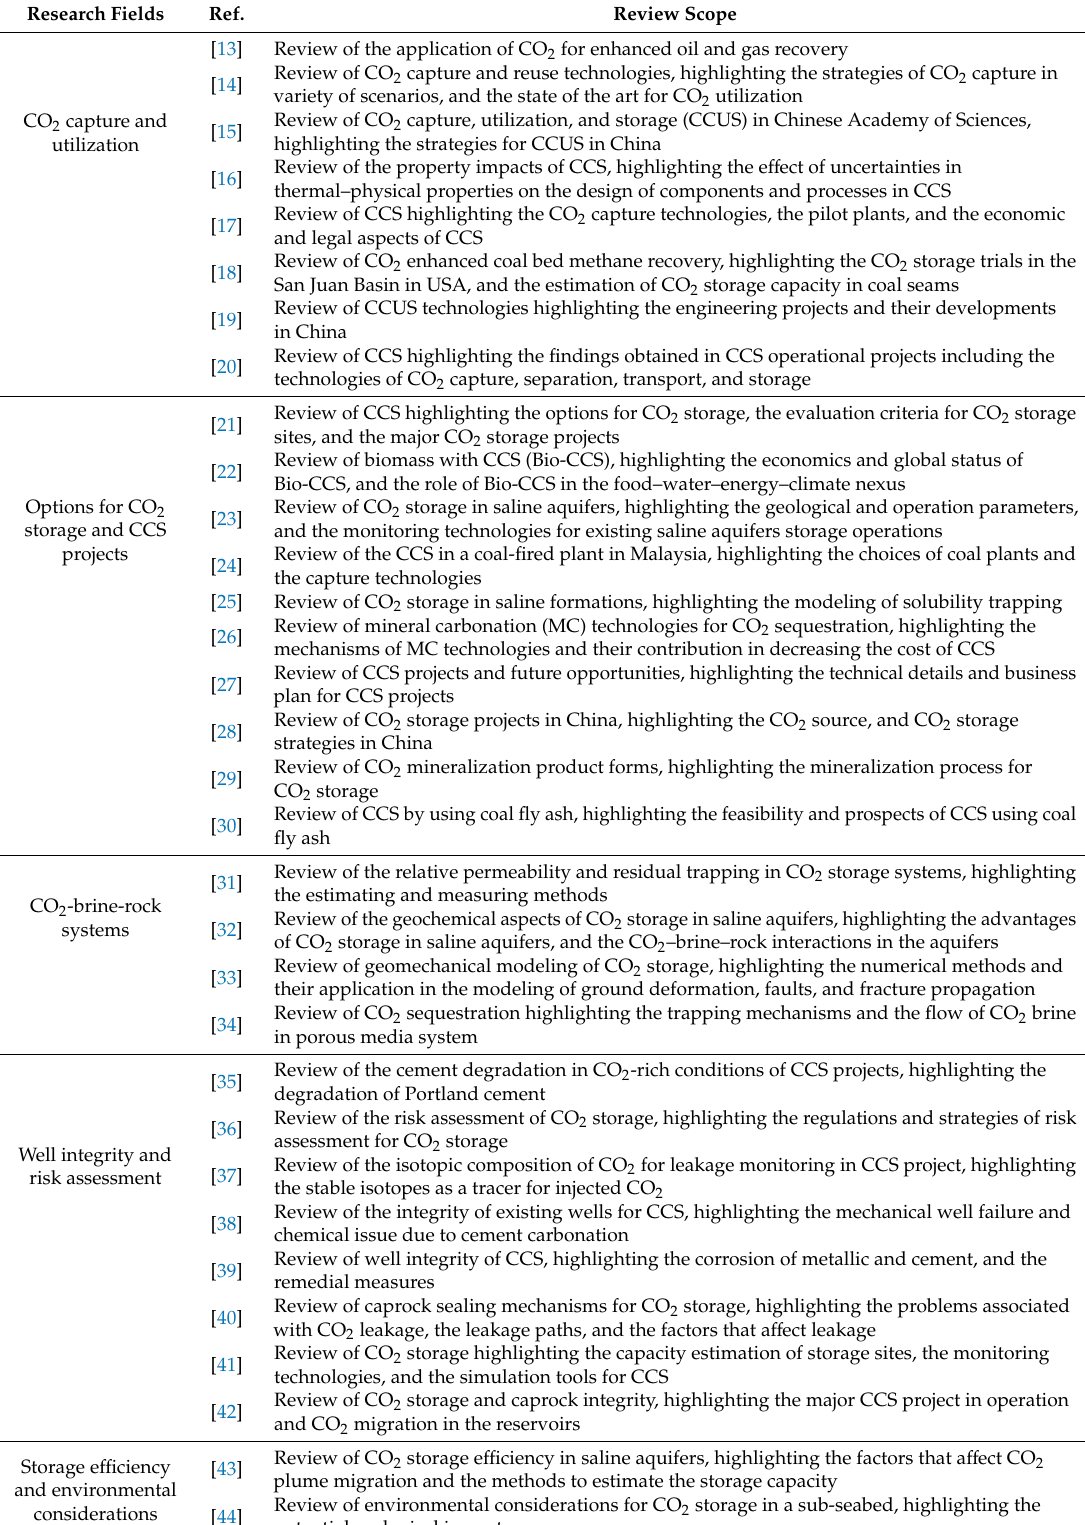
Table 1. Summary of review literature on CCS